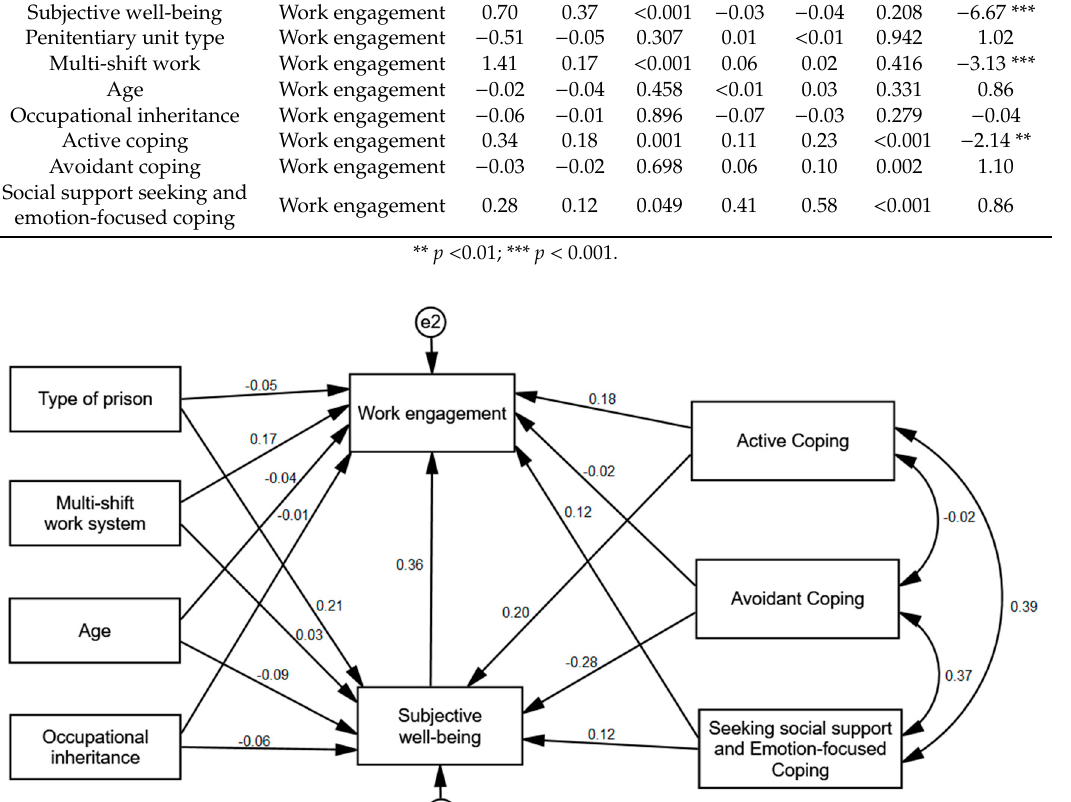
Figure 3. Standardized regression coefficients for the explanatory path model of work engagement in the group of Indonesian POs. The analysis showed that both groups differed in regard to the relationship between the penitentiary unit type and subjective well-being. Among Polish POs, the relationship between these variables was positive and weak, while among Indonesian POs, these variables were independent